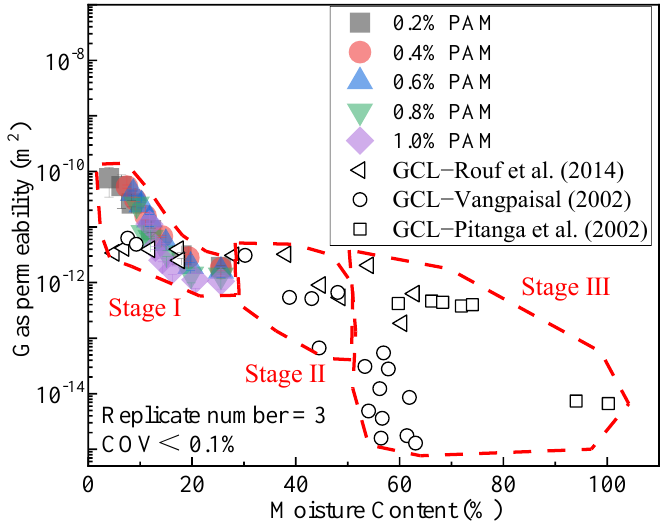
Figure 6 . Relationship between the gas permeability and moisture content of compacted clay after ZP modification [11,13,60]. ZP modification [11,13,60].